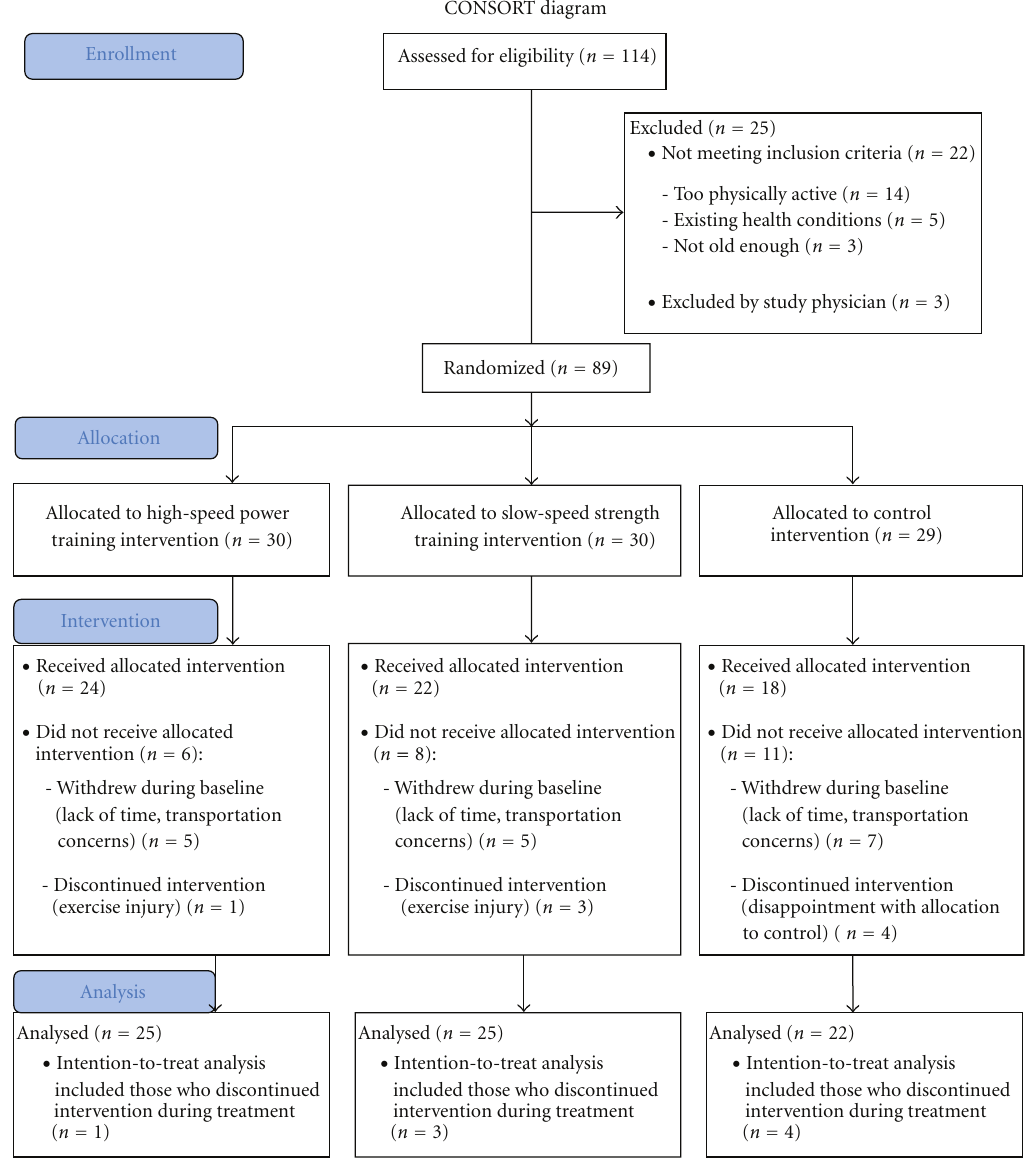
Figure 1: Overview of recruitment of study participants and randomization to study arms. HSPT = high-speed power training; SSST = slow-speed strength training; CON =